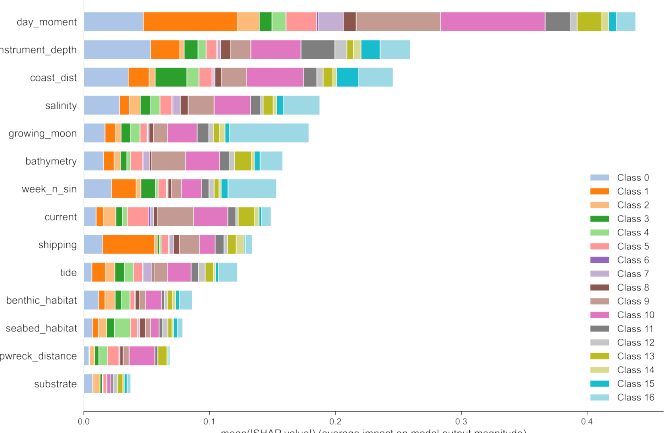
Figure 7. Global summary of the influence of the environmental parameters on the acoustic catego- rization in the entire